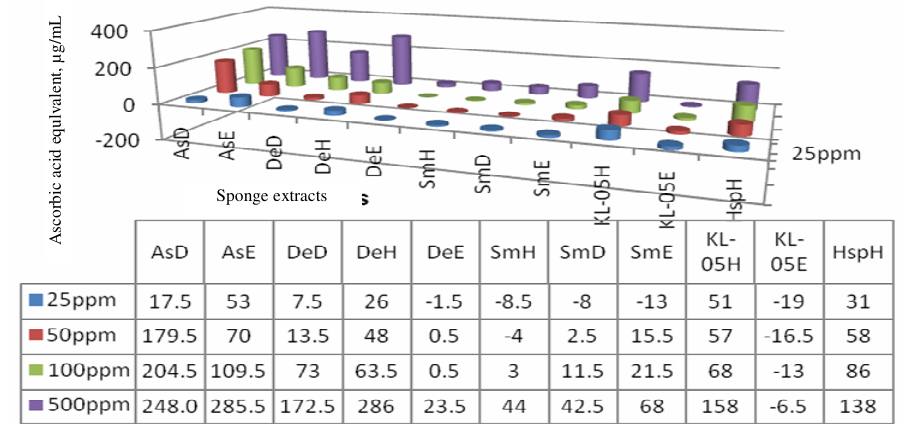
Figure 1. Total antioxidant activity of the extracts of A. suberitoides, D. elegans, S.